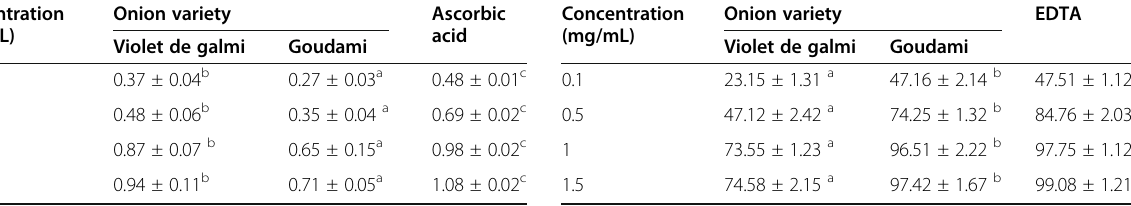
Table 3 Total Reducing Power of aqueous extracts of onions with standard Ascorbic Acid Concentration (mg/mL)